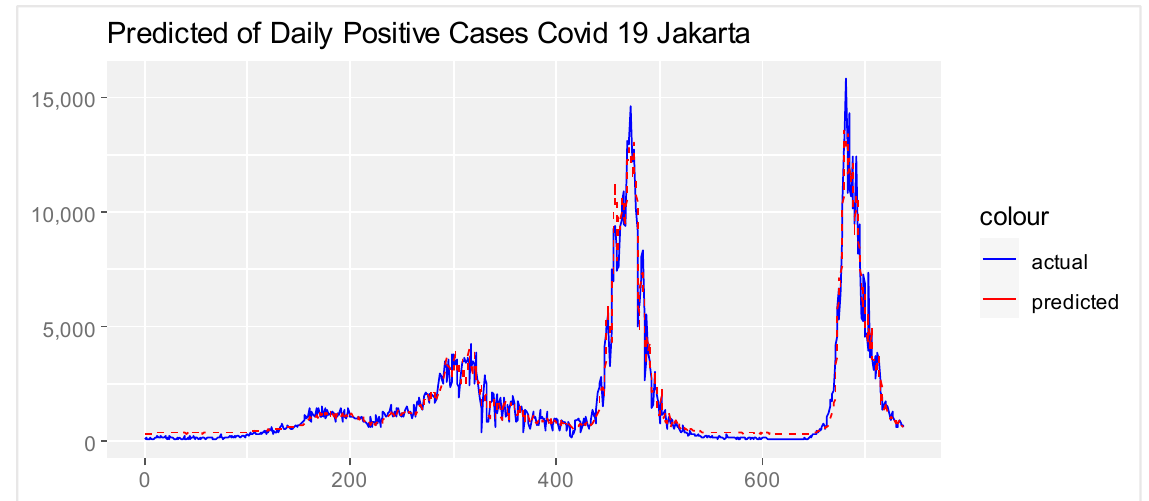
Figure 4. A plot of actual data and predicted data for daily confirmed positive cases of COVID-19 in Jakarta.